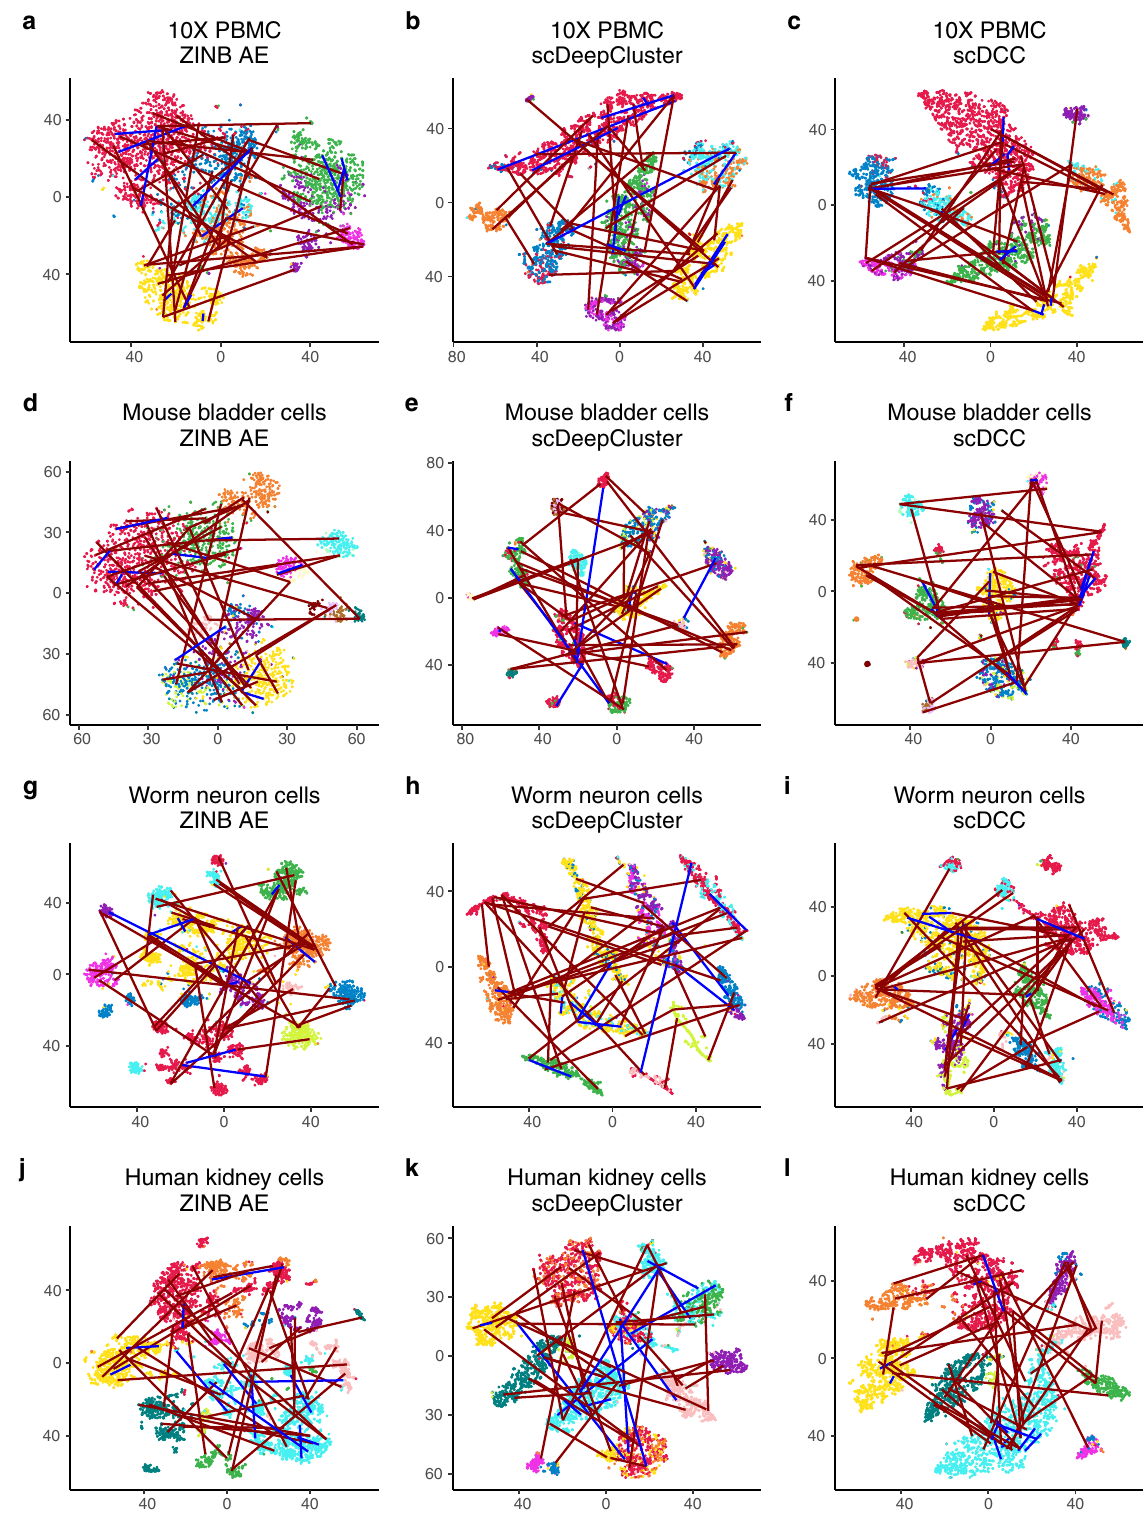
Fig. 3 Latent representation visualization. Comparison of 2D visualization of embedded representations of ZINB model-based autoencoder ( a , d , g , j ), scDeepCluster ( b , e , h , k ) and scDCC with pairwise constraints ( c , f , i , l ). The same instances and constraints are visualized for each dataset ( a – c , 10X PBMC; d – f Mouse bladder cells; g – i Worm neuron cells; j – l Human kidney cells). The red lines indicate cannot-link and blue lines indicate must-link. The axes are arbitrary units. Each point represents a cell. The distinct colors of the points represent the true labels, and colors are arbitrarily